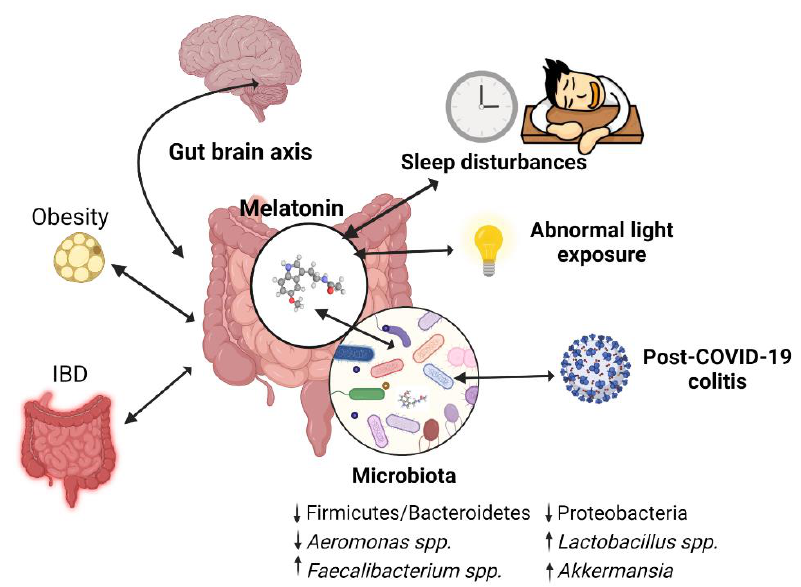
Figure 4. Dysbiosis-associated conditions where melatonin’s effects have been studied. The bidi- rectional arrows represent the mutual interactions between melatonin and these pathologies: while melatonin alleviates symptomatology through microbiota modulation, the dysbiosis which occurs in these conditions disrupts the intestinal mucosa, leading to a decreased synthesis of